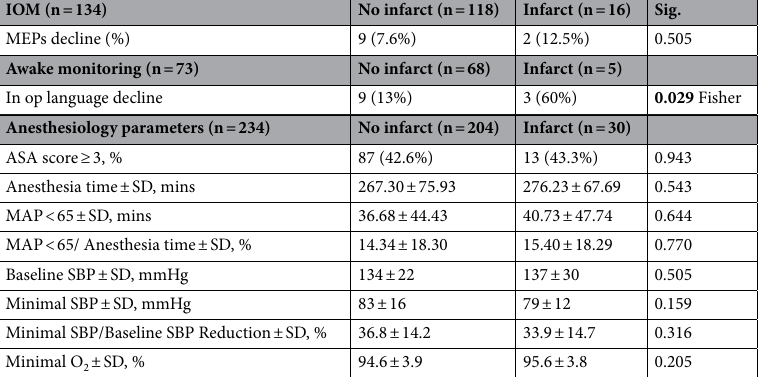
Table 3. Correlations between surgery-related infarcts and intraoperative parameters in intraoperative monitoring, awake surgery monitoring and anesthesiology parameters (univariate analysis). IOM intra- operative monitoring, MEP motor evoked potentials, ASA American Society of Anesthesiology score, SBP systolic blood pressure, MAP mean arterial pressure, SD standard deviation.